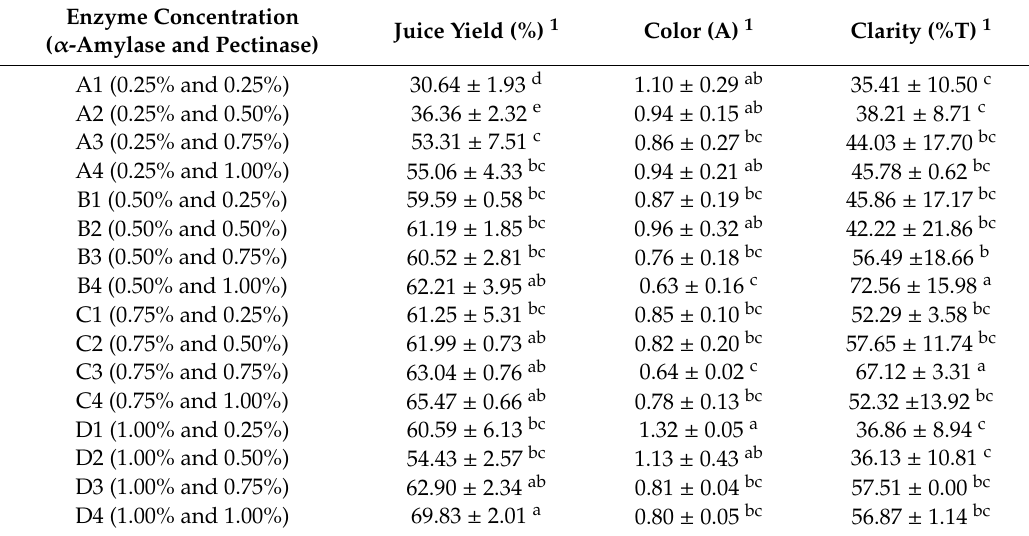
Table 1. Juice yield, color and clarity of ‘Saba’ banana juice treated with di ff erent enzyme concentrations. Enzyme Concentration